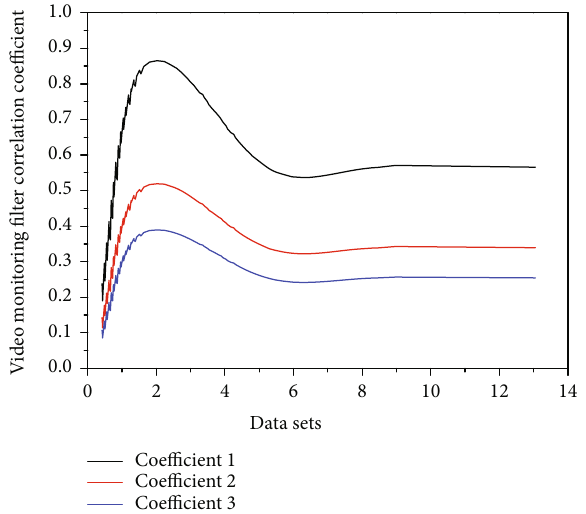
Figure 9: Video monitoring Gaussian fi lter correlation coe ffi cient